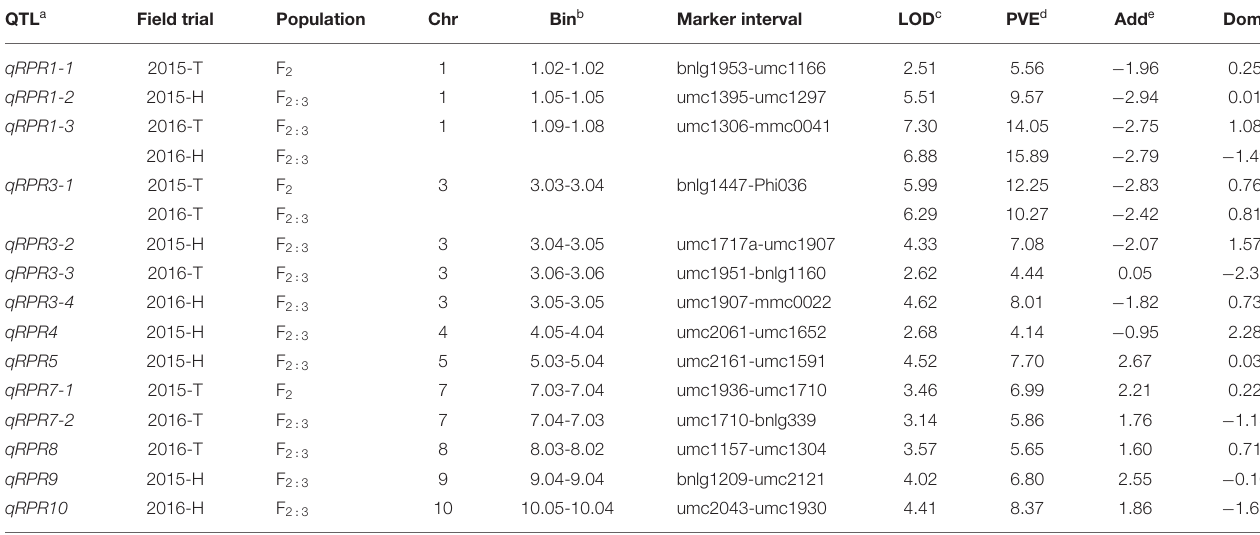
TABLE 2 | QTL for rind penetrometer resistance in F 2 and F 2 : 3 populations. QTL